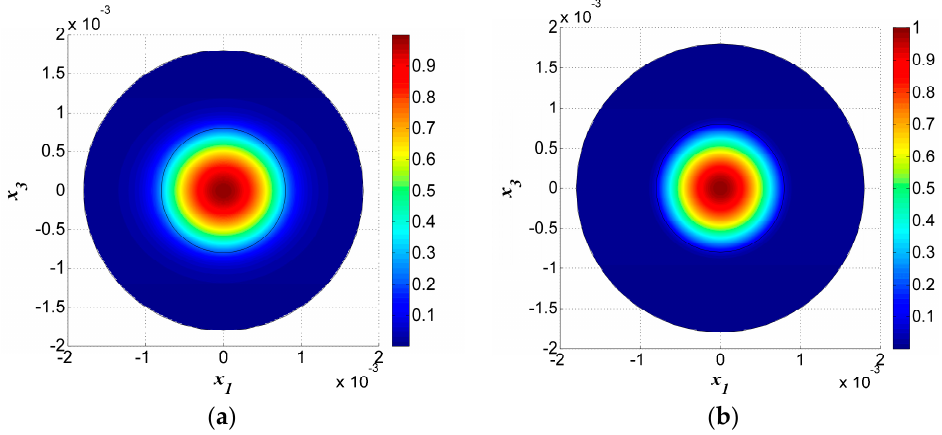
Figure 3. ( a ) Fundamental thickness-shear mode for n = 1, R = 5%, f = 1.586632 × 10 7 Hz. ( b ) The third overtone thickness-shear mode n = 3, R = 5%, f = 4.731520 × 10 7 Hz.